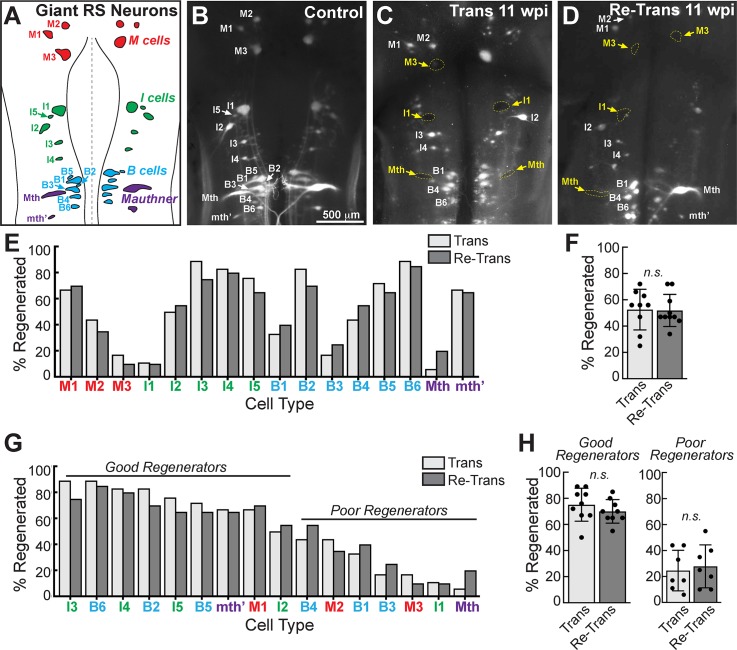
Regeneration of giant RS neurons is indistinguishable at 11 wpi after spinal transection and re-transection.(A) Diagram showing the giant RS neurons in the lamprey brain. These are the M, I, and B cells, as well as Mauthner neurons. (B) Retrograde labeling using tetramethylrhodamine dextran (10 kDa) in a control lamprey reveals all giant RS neurons. (C) In contrast, only a subset of giant RS neurons regenerate by 11 wpi after spinal transection (white labels), as identified by dye labeling, while others fail to regenerate and are therefore devoid of dye (yellow labels). (D) A similar cohort of regenerated neurons is labeled at 11 wpi after spinal re-transection. Scale bar in B also applies to C-D. (E) Cell-by-cell analysis of giant RS neuron regeneration from a population of n = 10 lampreys. There are no obvious differences in regeneration by cell type. (F) Similarly, the percentage of all giant RS neurons that regenerated was similar in transected and re-transected lampreys. (G-H) Likewise, there were no obvious differences in regeneration of either “good regenerators” or “poor regenerators.” Bars in F and H represent mean ± SD per brain from n = 10 lampreys. n.s. indicates “not significant” by unpaired Students t-Test (p>0.05).